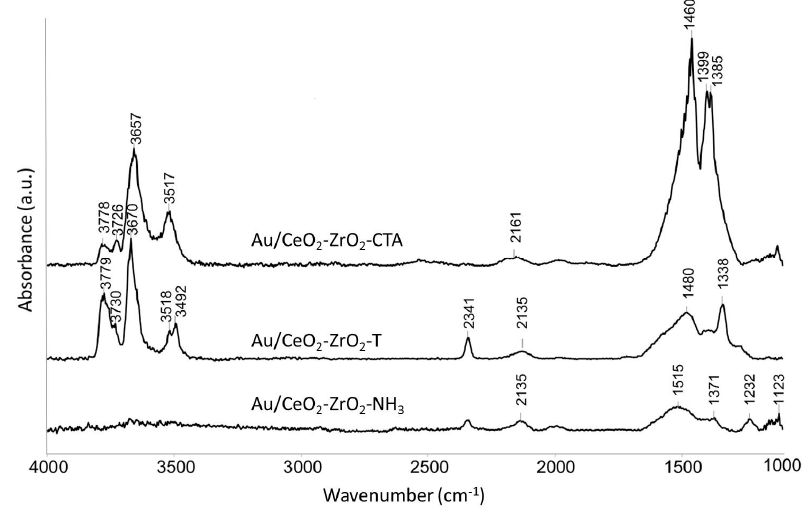
◦ C, 2 h, vacuum) oxidized Au/CeO ◦ C. Figure 6. IR spectra of activated (500 °C, 2 h, vacuum) oxidized Au/CeO 2 -ZrO 2 -catalysts at 50 °C. Figure 6. IR spectra of activated (500 2 -ZrO 2 -catalysts at 50 Bands were observed at 3779, 3670, and 3518 cm − 1 indicating the type I-, II-, and III-